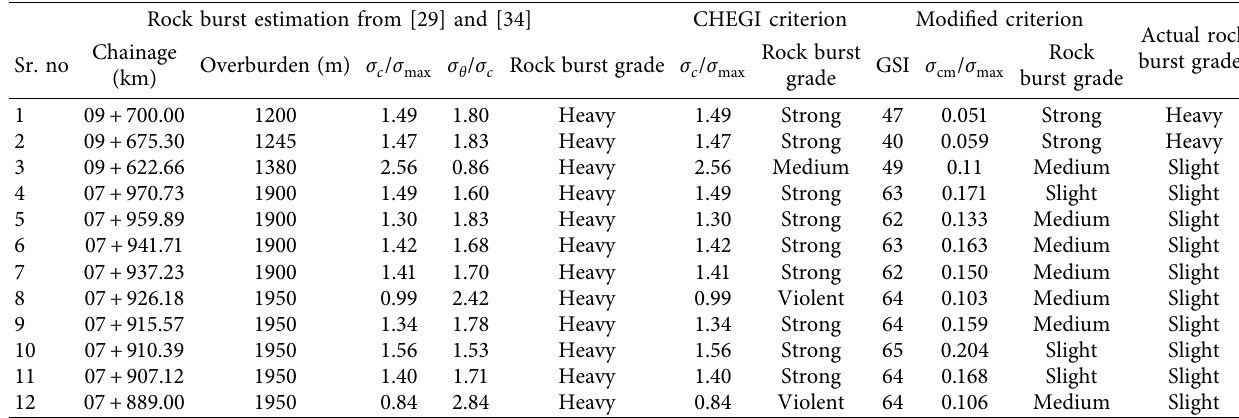
Table 17: Comparison of estimation results.